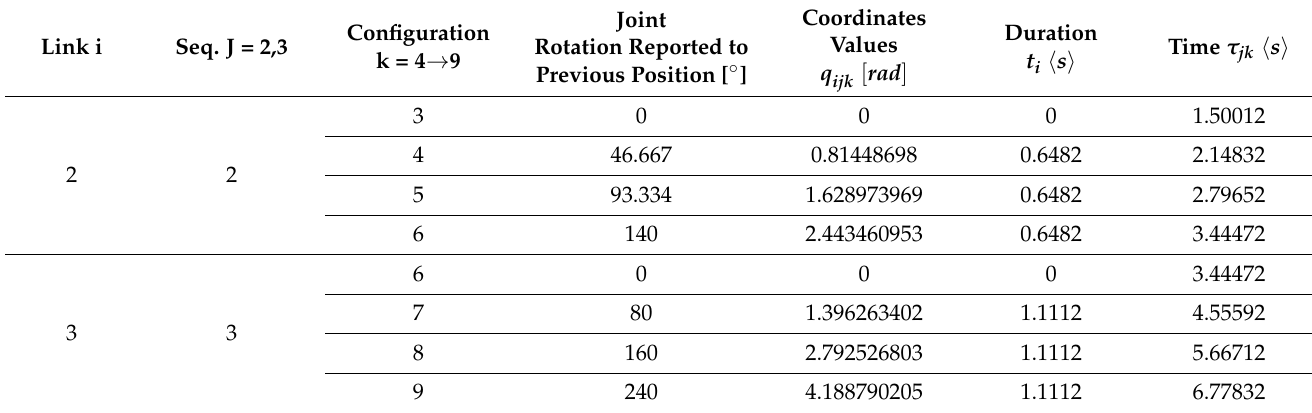
Table 2. CardioVR-ReTone joints j2, j3—coordinates and running times.